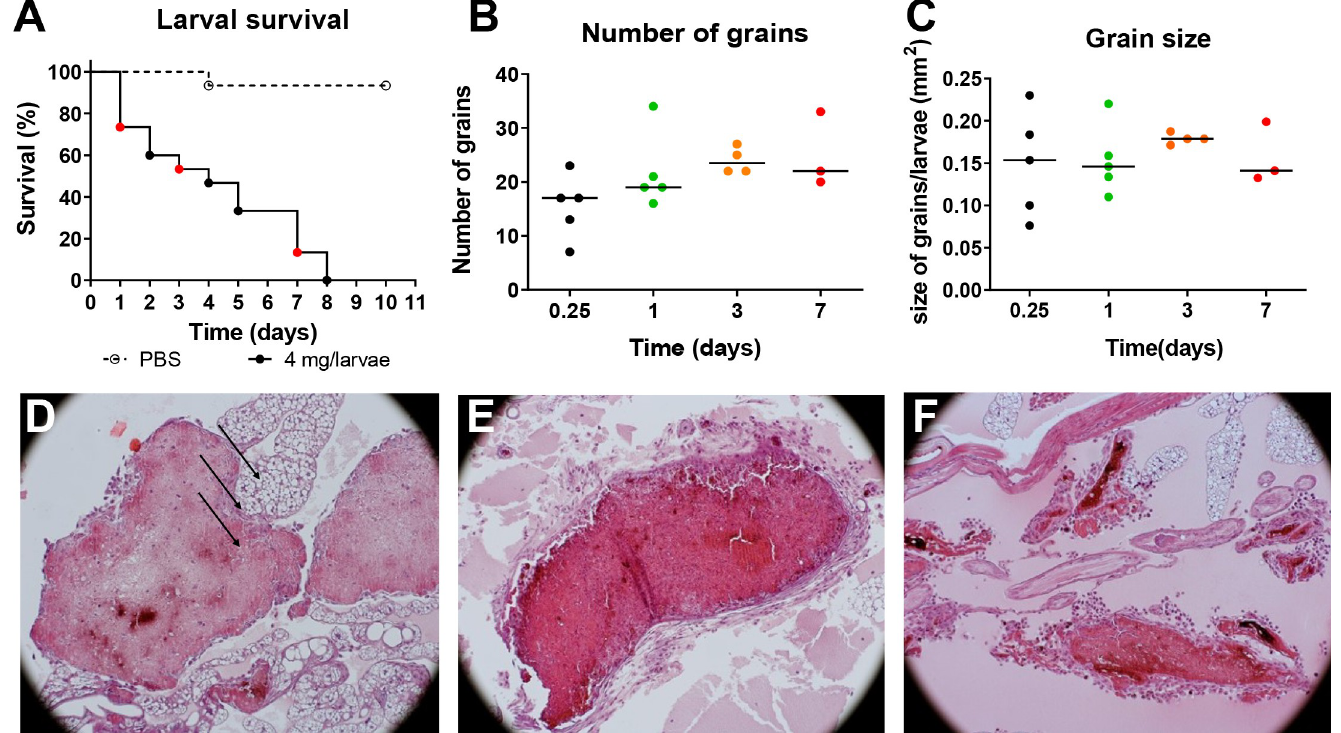
Fig 1. M . mycetomatis infection in G . mellonella larvae over time. A: Larval survival of PBS infected (---) and M . mycetomatis infected (———) larvae over 10 days, each day is represented with a dot. B: The number of M . mycetomatis grains present in the infected G . mellonella larvae at day 1, 3, and 7 after fungal inoculation as assessed by histology. C: The size of the M . mycetomatis grains present in the infected G . mellonella larvae at day 1, 3, and 7 after fungal inoculation as assessed by histology. D: Hematoxylin Eosin (HE) staining of a M . mycetomatis grain in a G . mellonella larvae, 1 day after fungal inoculation. Arrows, indicate the presence of hemocyte within the cement material of the grain. E: HE staining of a M . mycetomatis grain in a G . mellonella larvae, 3 days after fungal inoculation. F: HE staining of a M . mycetomatis grain in a G . mellonella larvae, 7 days after fungal inoculation.